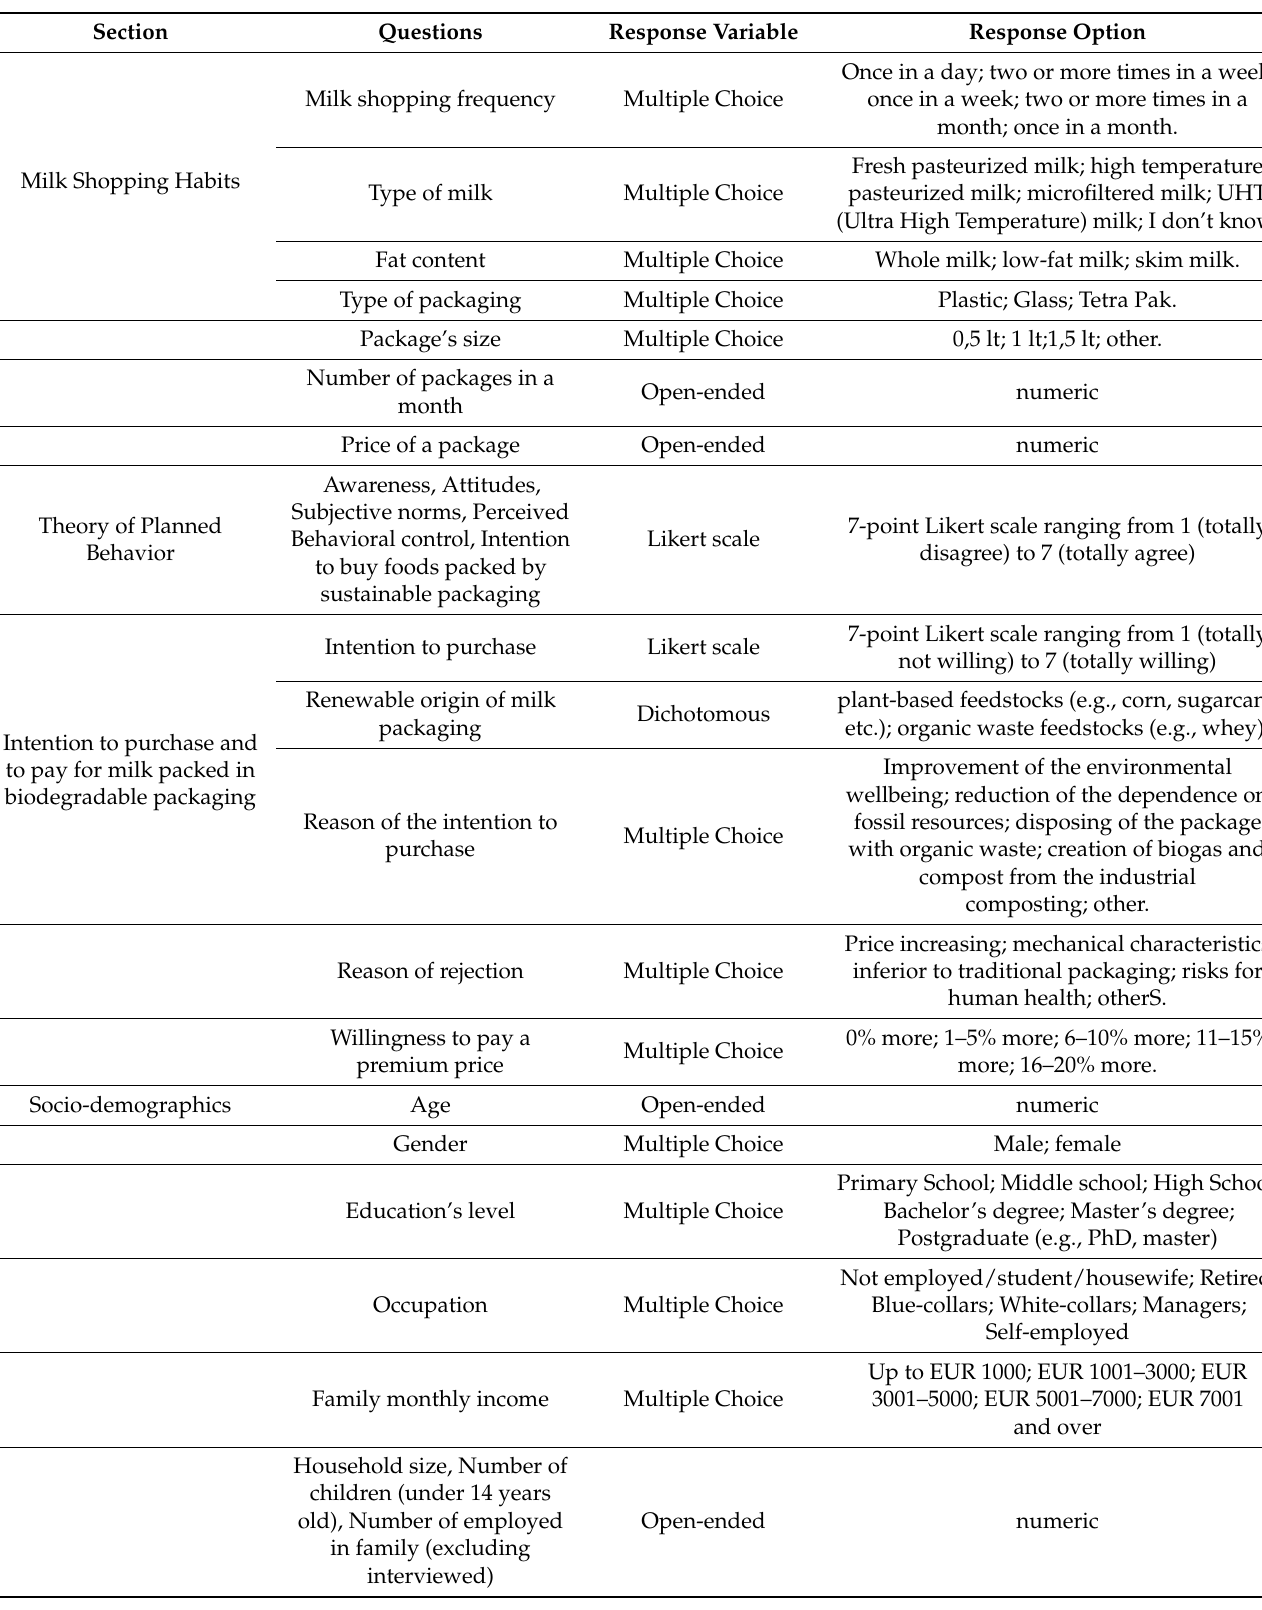
Table A2. The questionnaire’s